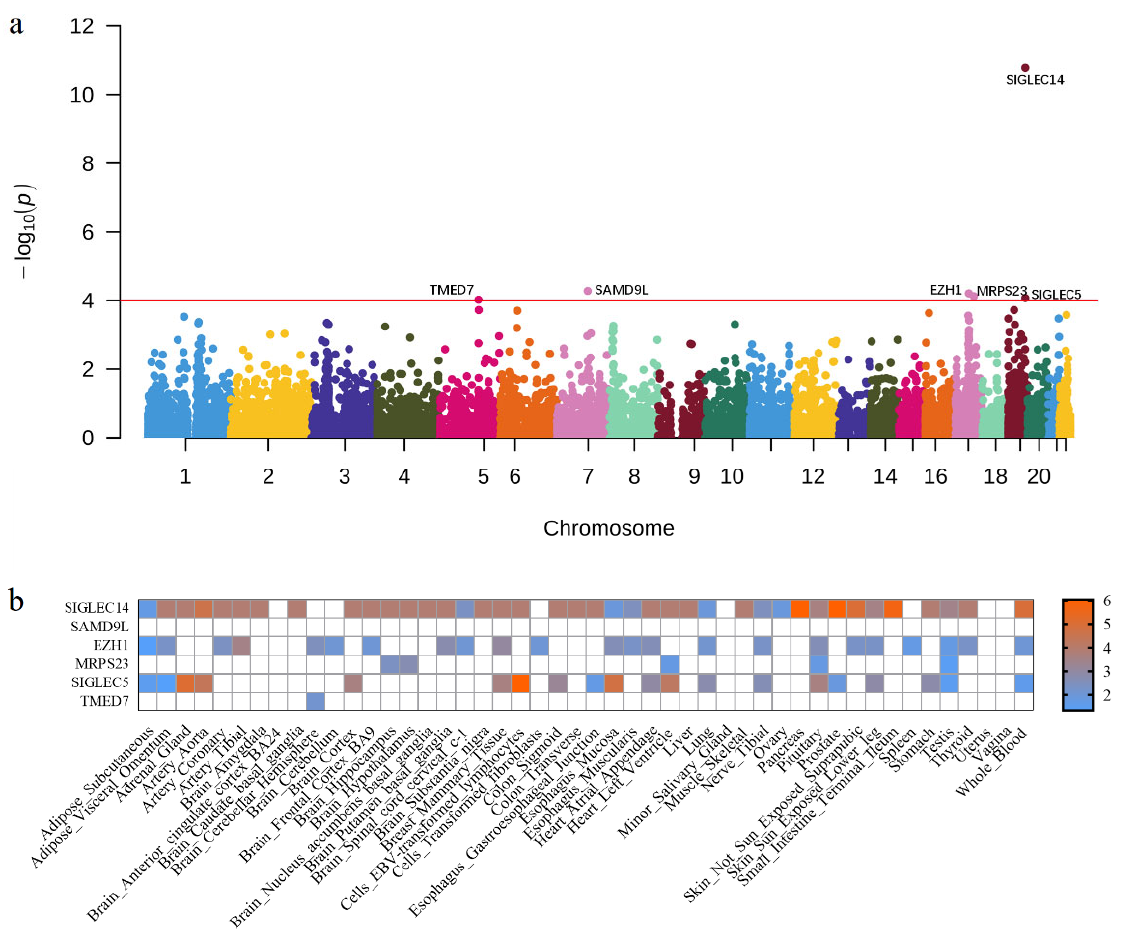
Figure 3. Transcriptome-wide association study results for periodontitis. ( a ) Manhattan plot of cross-tissue TWAS using UTMOST. The y-axis represents the p -value in − log10 scale. Genes with p -value < 1 × 10 − 4 are labeled. ( b ) The heatmaps of the six genes are segregated by tissues. The statistics represent the p -value of FUSION on a − log10 scale. The white lattice represents P FUSION > 0.05 or unavailable statistics. TWAS, transcriptome-wide association study. Table 1. Significant genes in the TWAS analysis of periodontitis.